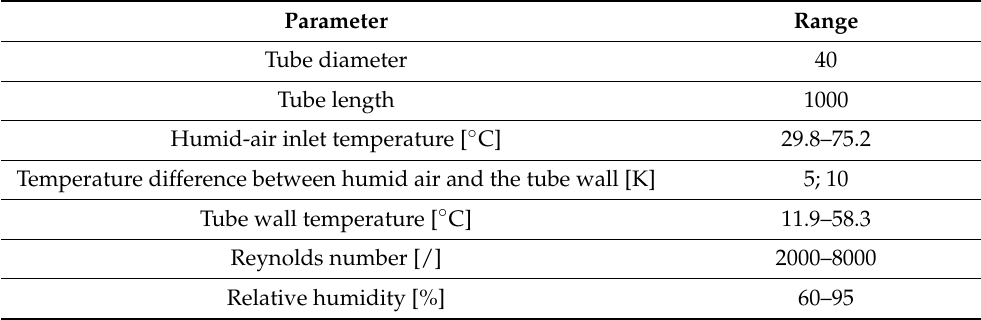
Table A4. Range of process parameters valid for existing correlation for horizontal tubes